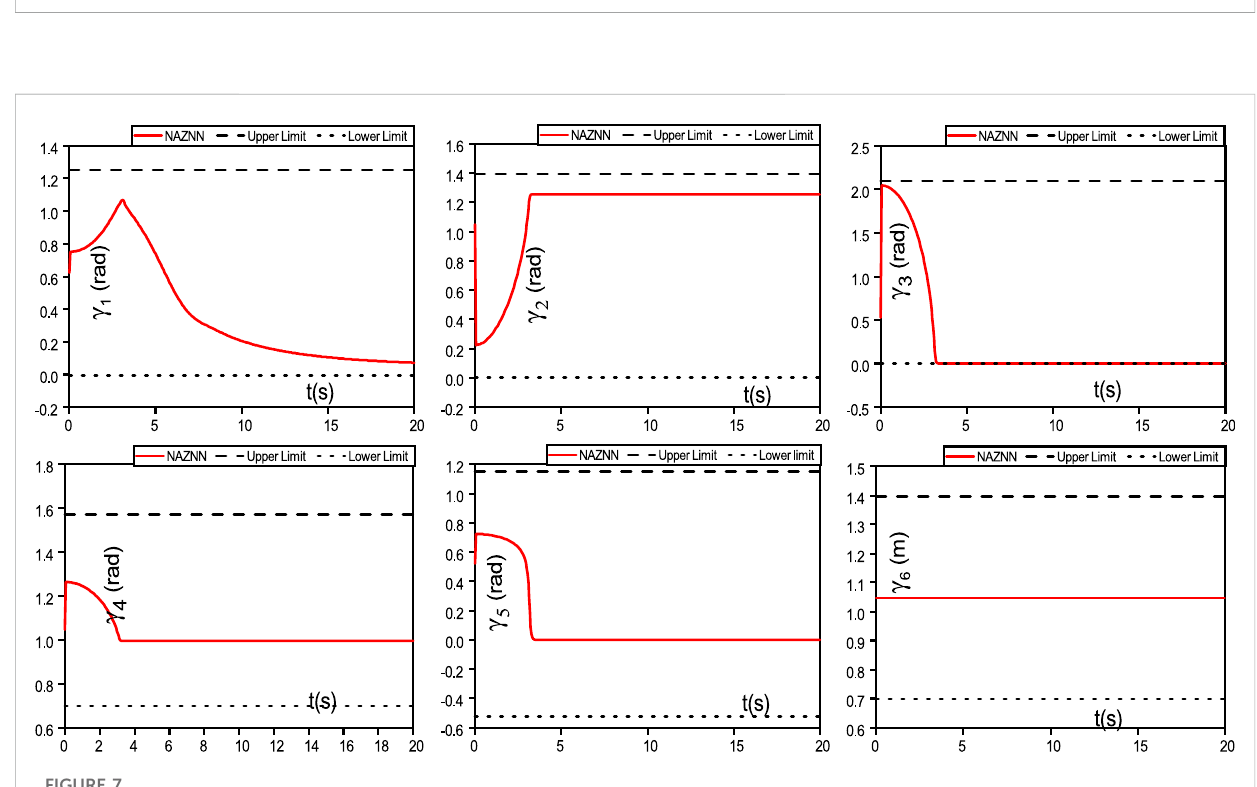
FIGURE 7 The NAZNN model-controlled wheeled robots trajectory tracking with 6 joint angle